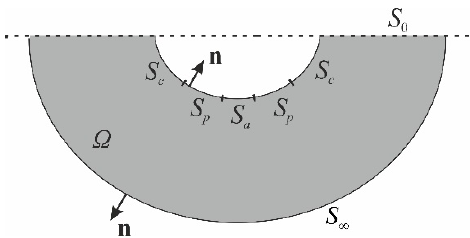
Figure 1. Illustration of an impressed current cathodic protection (ICCP) problem of a structure immersed in a semi-infinitely extended electrolyte.